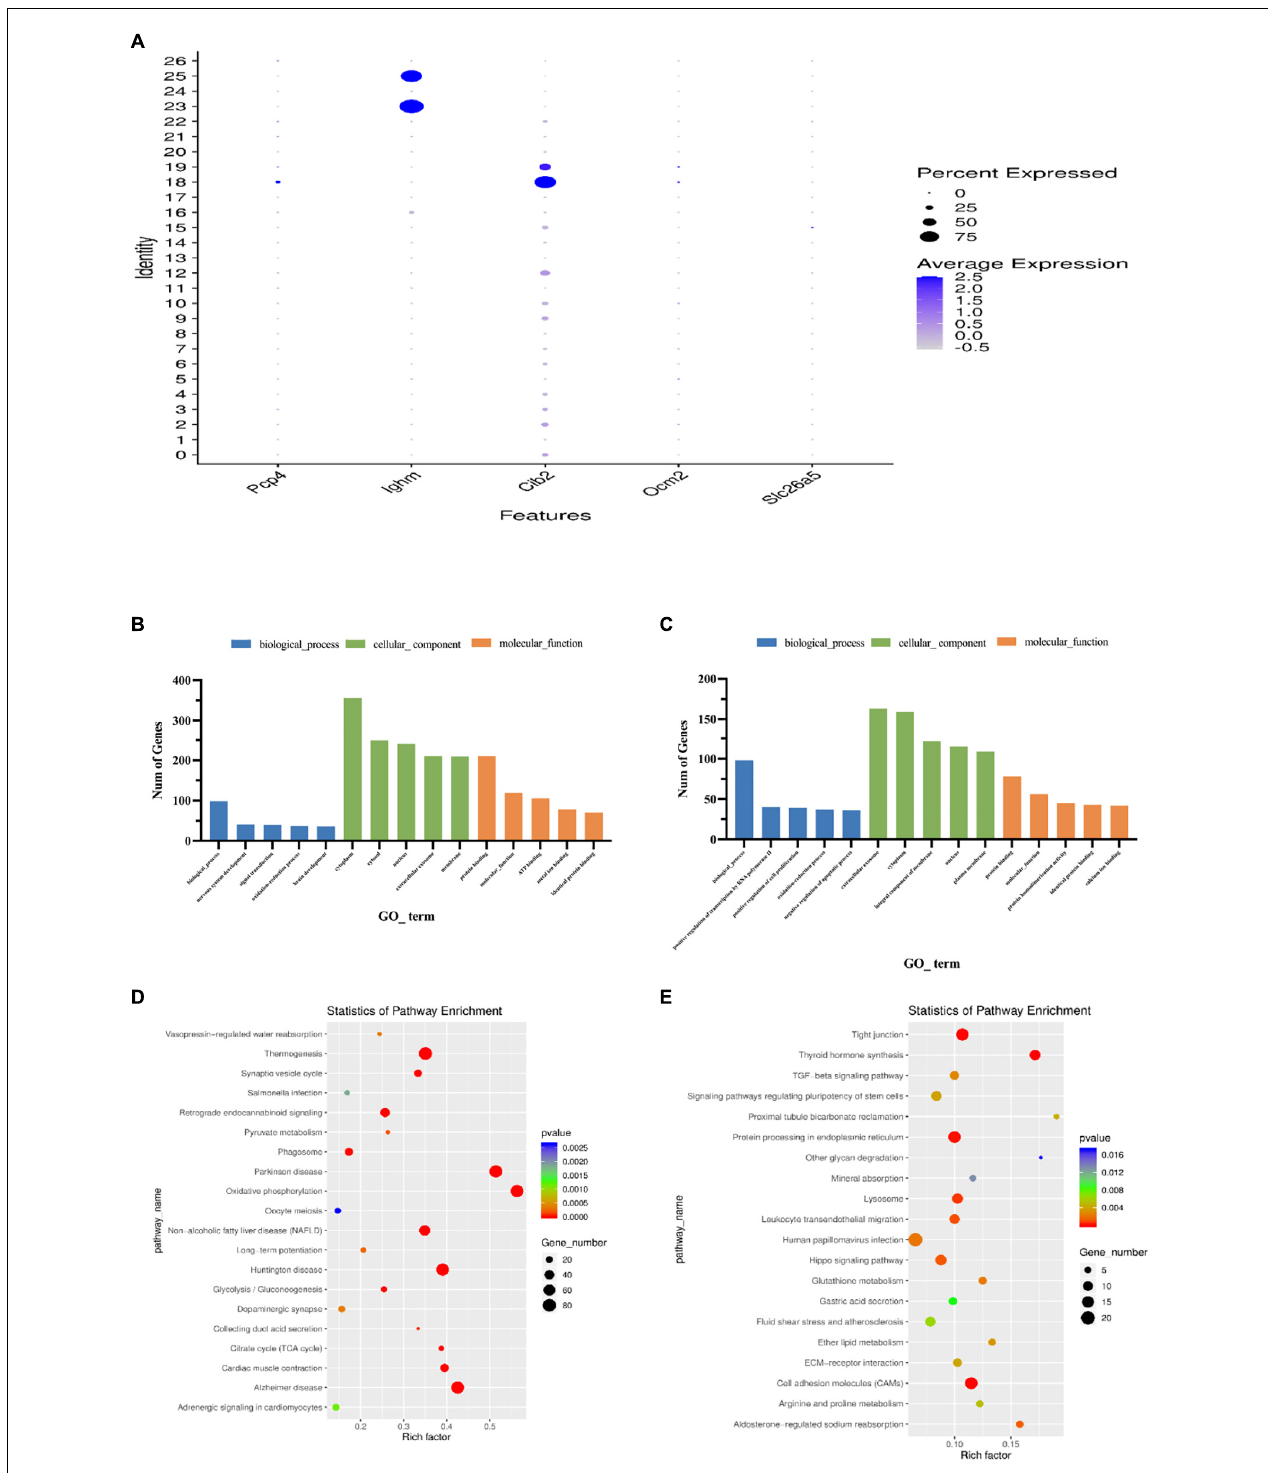
FIGURE 7 | Features of outer hair cell subtypes. (A) Accumulation of marker gene transcripts by cluster. This dot plot indicates the level of marker gene expression (dot intensity) and the fraction of cells in each cluster expressing a given marker gene (dot size). (B) GO enrichment analysis of genes for cluster 18. (C) GO enrichment analysis of genes for cluster 19. (D) Functional enrichment analyses using KEGG pathways for cluster 18. (E) Functional enrichment analyses using KEGG pathways for cluster 19. The x-axis is the item of go function, the ordinate represents the enriched genes by each item, and the cycle size indicates the significance and corresponding significance values displayed as log10 ( P